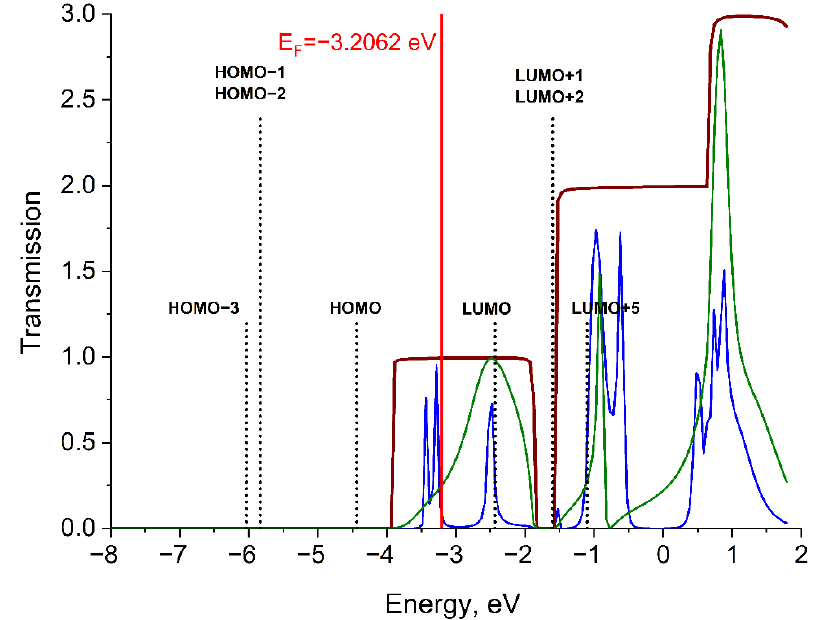
Figure 3. Transmission functions T DMT (E) (green for d(Li-Mo) = 2.90 Å and blue for d(Li-Mo) = 3.10 Å) for the Li 6 – DMT – Li 6 system and transmission function T wire (E) (brown) for the Li 6 -Li 6 system. E F denotes the Fermi level of electrodes. Energy positions of bonding ( σ , π , δ ) and antibonding ( σ *, π *, δ *) MOs are shown by vertical lines (black dots).